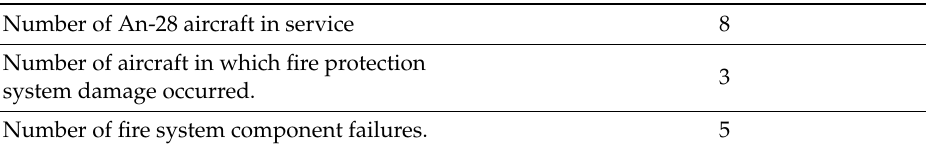
Table 1. Number of failure